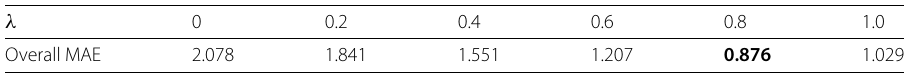
Table 8 Overall MAE at different values of λ λ 0 0.2 0.4 0.6 0.8 1.0 Overall MAE 2.078 1.841 1.551 1.207 0.876